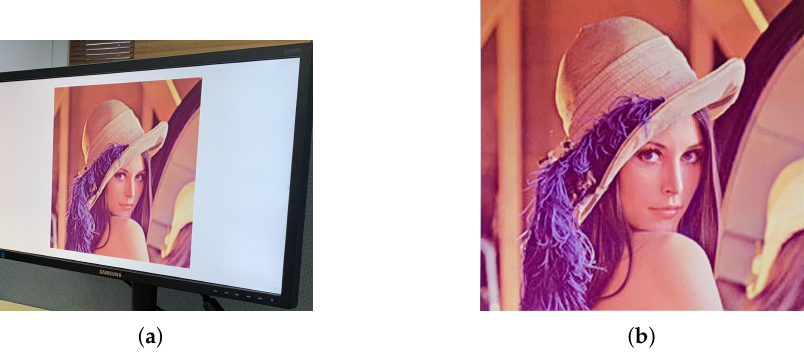
Figure 5. Image extraction process. ( a ) Cropped image. ( b ) Distortion-corrected